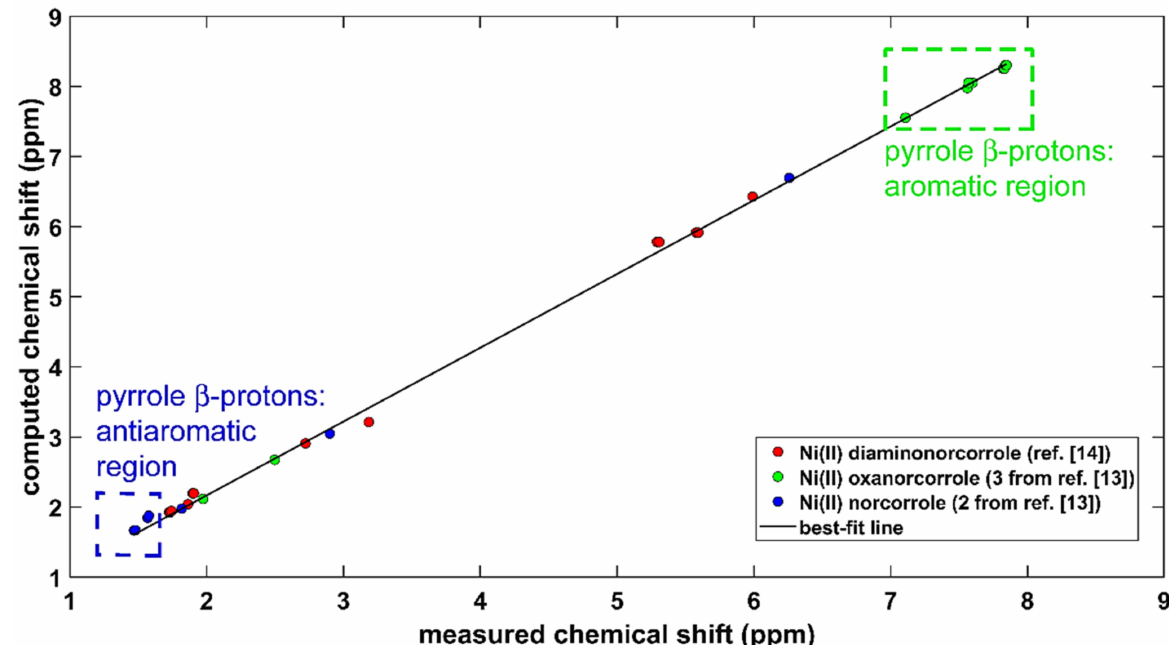
Figure 2. Comparison of the GIAO-B3LYP/6-311++G(2d,2p) and experimental 1 H chemical shifts (in ppm) in chloroform of three compounds specified in the